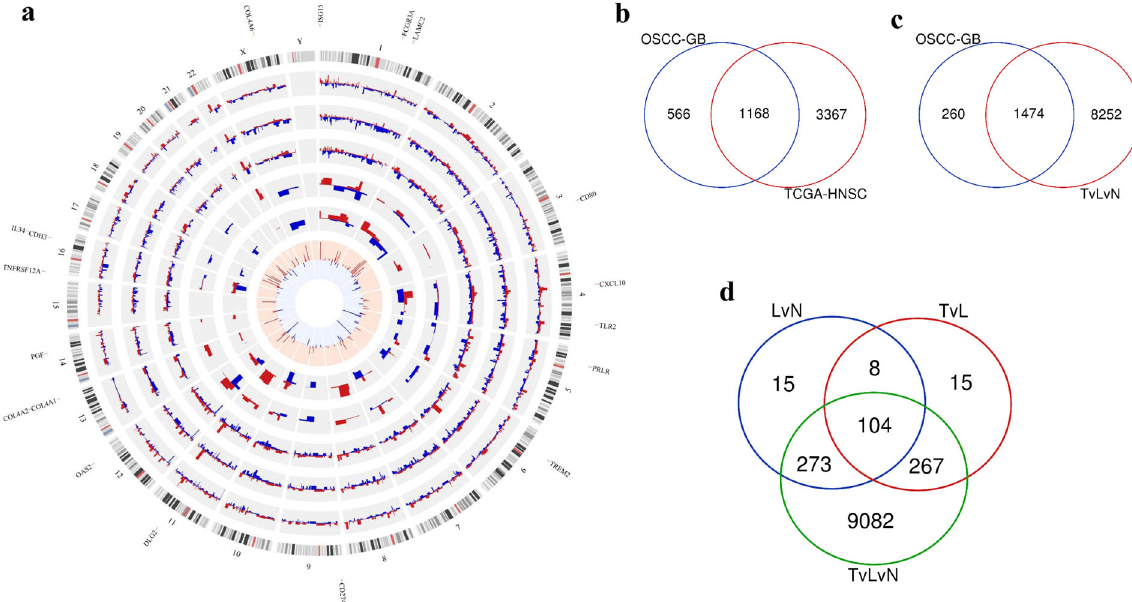
Fig. 1 Transcriptomic landscape of development and progression of OSCC-GB. a Circos plot depicting differential gene expression pro fi les in relation to gradual malignant transformation and development of gingivo-buccal oral cancer from normal. The outermost track represents the ideogram of the human reference genome (hg19). Second and third tracks provide transcriptomic pro fi les of signi fi cantly differentially expressed coding genes identi fi ed and validated from the independent sets of discovery and validation cohort patients, respectively. The fourth track depicts chromosome-wise distribution of 1168 genes found signi fi cantly deregulated in the TCGA-HNSC patients in addition to OSCC-GB patients. Fifth and sixth tracks represent fold changes of 104 signi fi cantly deregulated genes, with potential involvement in malignant progression to OSCC-GB, from tumor vs. leukoplakia and leukoplakia vs. normal sample comparisons, respectively. For all six outer tracks (excluding the outermost), red and blue histograms depict fold changes in upregulated and downregulated genes, respectively. The innermost track shows red and blue bars for 175 upregulated and 93 downregulated genes from one or more KEGG pathways signi fi cantly enriched in OSCC-GB patients, respectively. The height of each bar represents the number of enriched pathway(s) in which a gene is involved. Eighteen genes, with potential involvement in oral cancer progression, from the enriched KEGG pathways, are shown outside the ideogram. Overlap of genes, signi fi cantly differentially expressed between ( b ) patients derived from gingivo-buccal oral cancer (OSCC-GB) and head and neck cancer (TCGA-HNSC). c OSCC-GB development and three-group (TvLvN) comparisons d leukoplakia vs. normal (LvN), tumor vs. leukoplakia (TvL), and three-group (TvLvN)